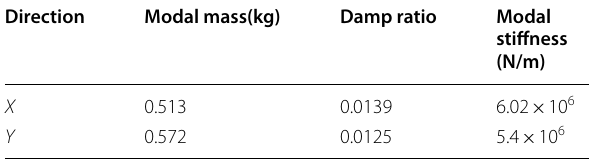
Table 1 Modal parameters of the machine